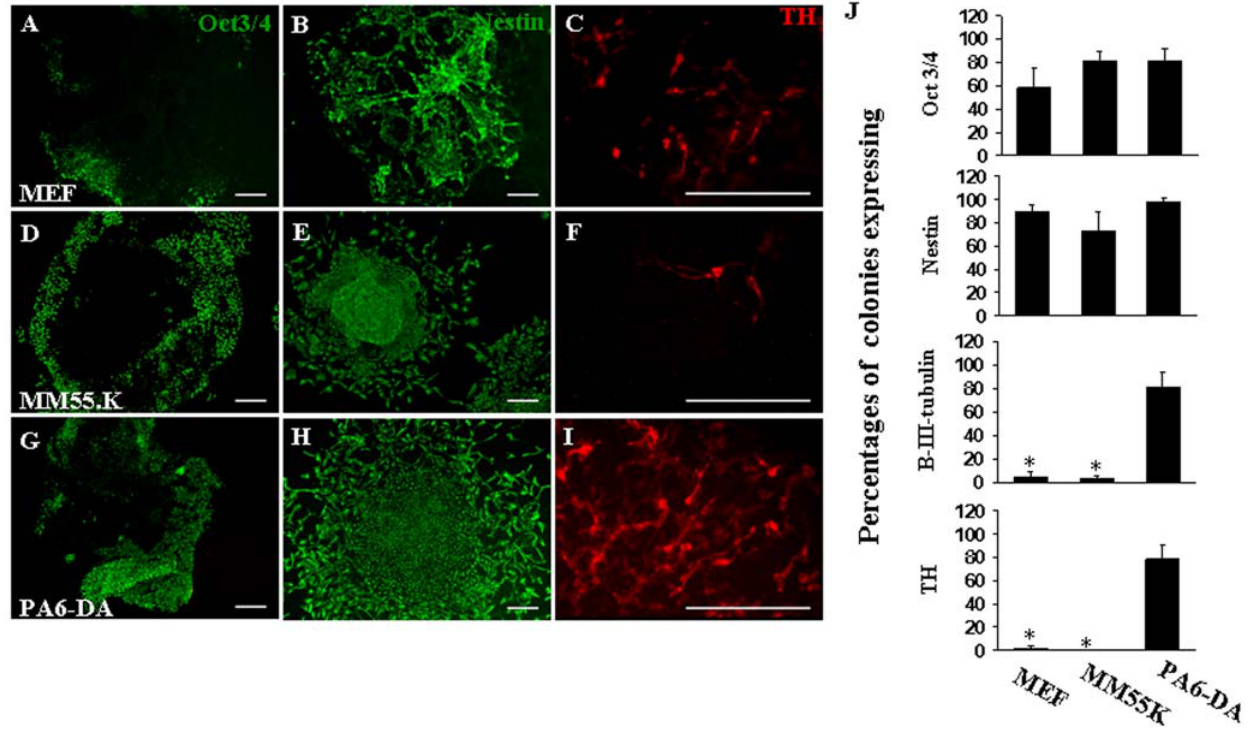
Figure 1. Marker expression analysis of differentiating hESC in co-cultures. BG01V2 colonies co-cultured with MEF (A–C), MM55K (D–F), and PA6-DA (G-I) for 12 days. Expression of the stem cell marker Oct3/4 was detected in more than half of the colonies grown of MEF (A), while 82% of colonies cultured on MM55K (D) and PA6-DA (G) contained Oct3/4 + cells. The early neuronal marker nestin was expressed in the majority of colonies in co-culture with MEF (B), MM55K (E), and PA6-DA (H) cells. The presence of dopaminergic neurons, identified by expression of TH, was found in 2% of colonies in MEF co-cultures (C) and in less than 1% of colonies grown on MM55K cells (F). The majority of colonies cultured on PA6-DA contained large numbers of TH + neurons (I). Quantification of percentages of colonies expressing Oct3/4, Nestin, b -III-tubulin and TH after 12 days of co-culture on MEF, MM55K or PA6-DA feeder cells are presented as bar graphs with error bars indicating standard deviations. Data represent 60 colonies from three independent experiments (J). The overall difference in TH and b -III- tubulin expressing colonies was statistically significant in conditions with MEF and MM55K cells (P , 0.0001), as compared to PA6-DA co-cultures. Scale bar=200 m m. doi:10.1371/journal.pone.0006606.g001 PLoS ONE |